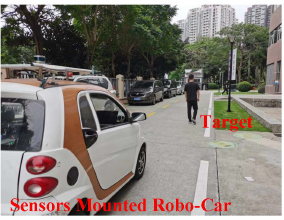
Figure 21. Robocar Robotic Platform mounted with Senors in Outside